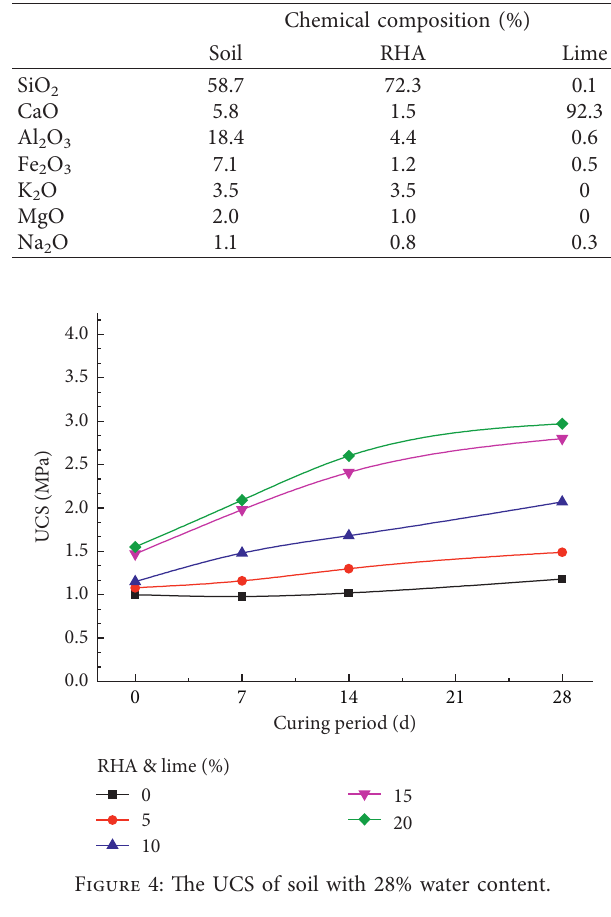
Figure 4: The UCS of soil with 28% water content.